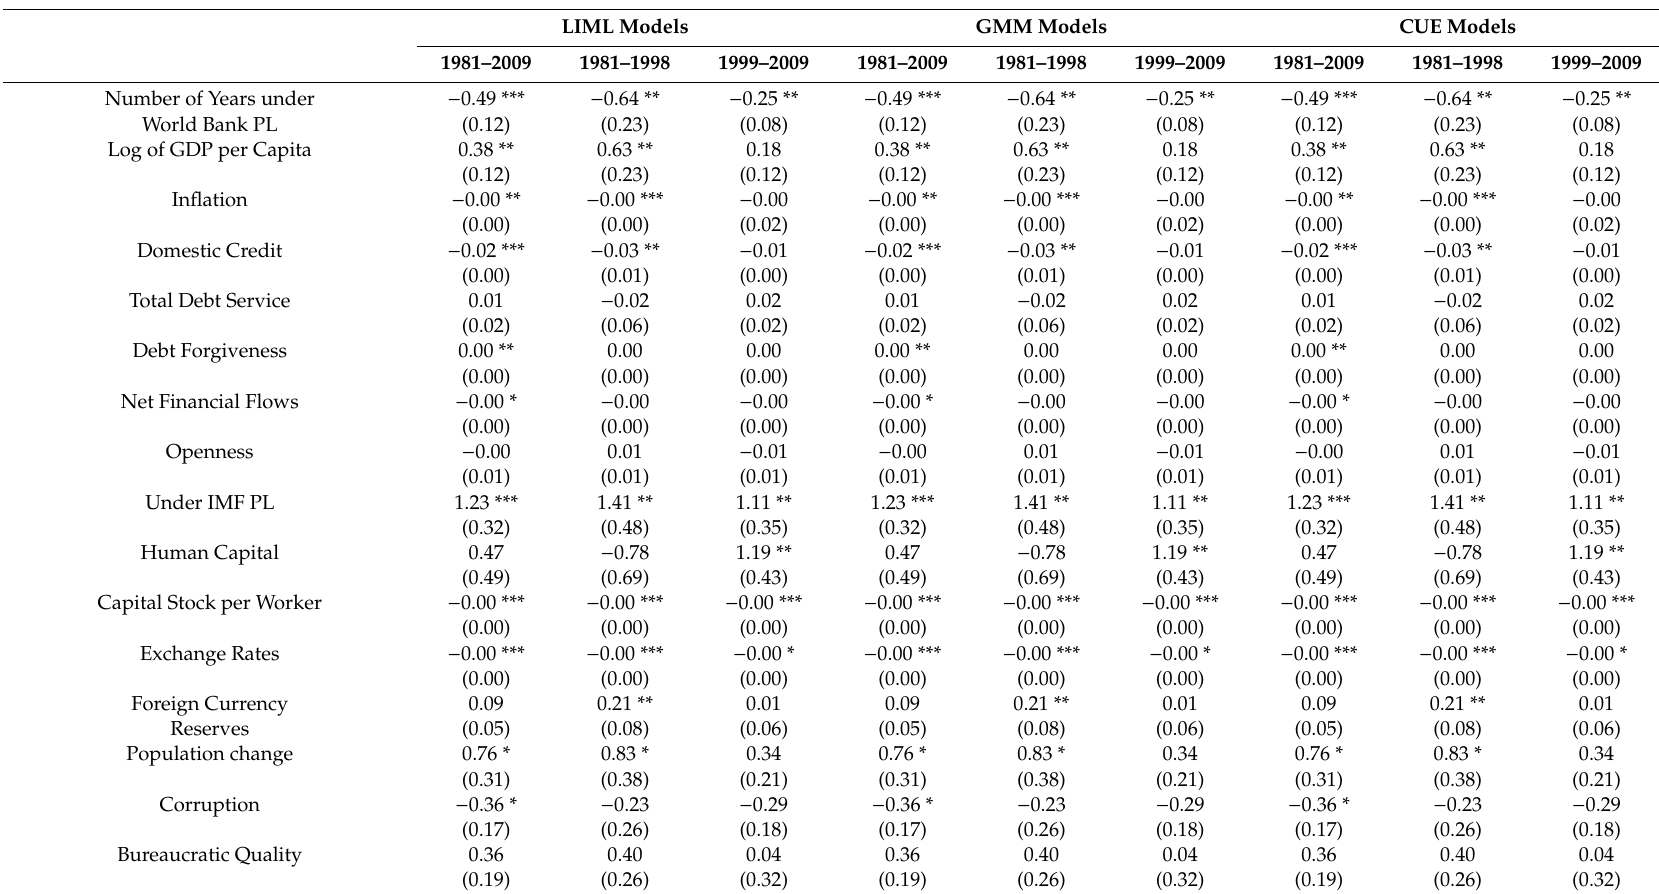
Table A2. Alternate Instrumental Variables Regression Models: Limited Information Maximum Likelihood (LIML), Generalized Methods of Moments (GMM) and Continuously Updated Estimator (CUE) Models: World Bank Program Lending and Its E ff ects on Economic Growth, 1981–2009, All Developing Countries with Regional and Annual Fixed E ff